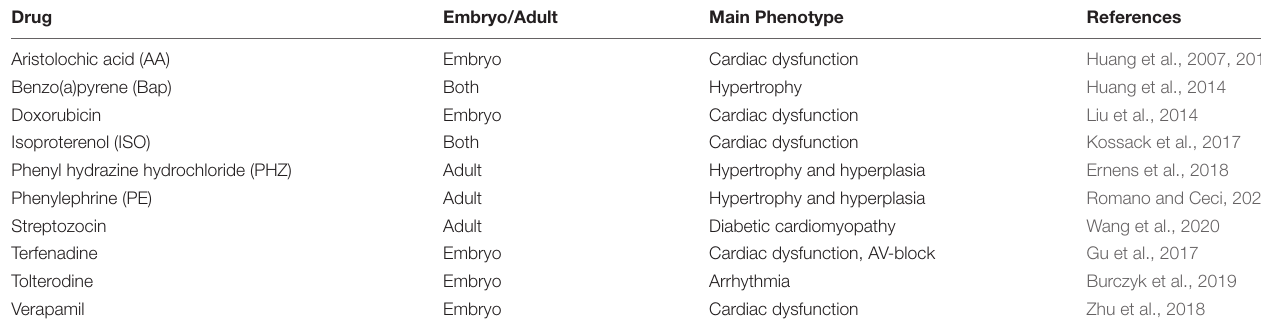
TABLE 3 | Drug-induced models of heart